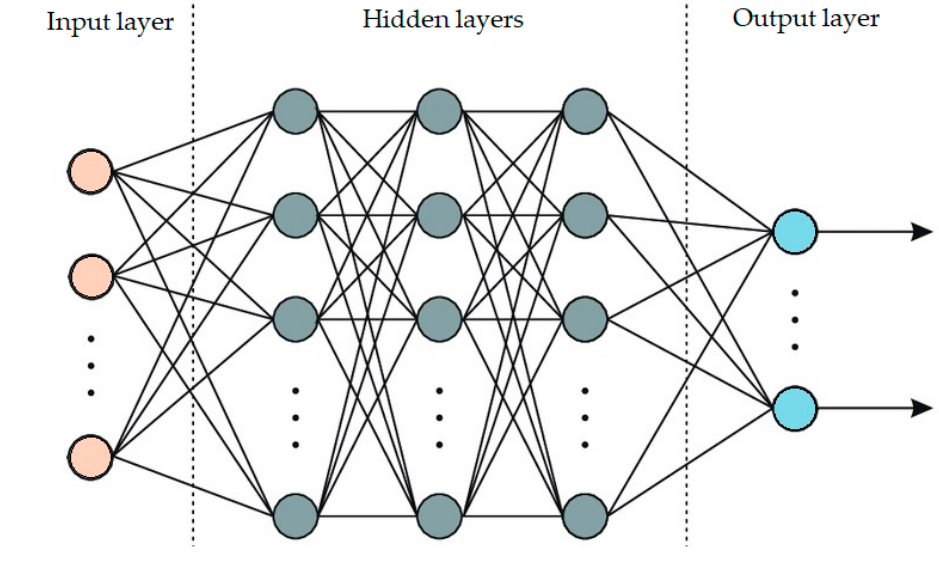
Figure 3. Model of Artificial Neural Network.